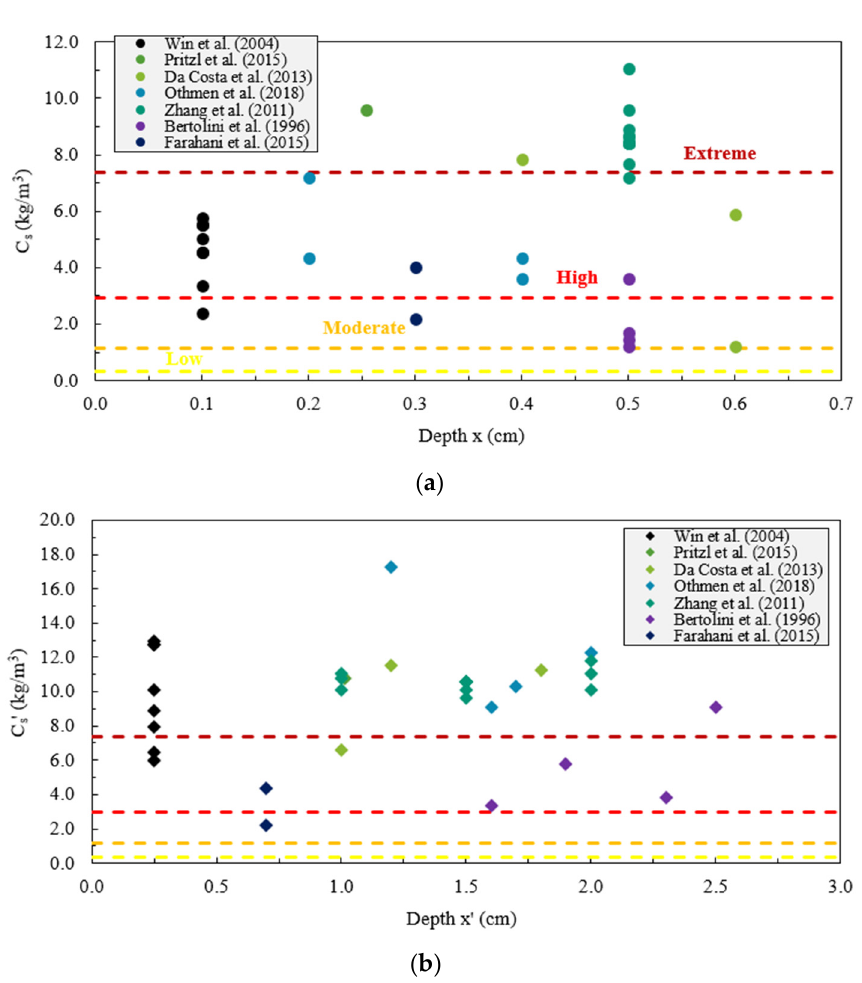
Figure 6. Collected data: ( a ) C s at depth x and ( b ) C s ’ at depth x’ retrieved from literature [13,25–30]. The horizontal lines indicate the four levels of aggressiveness (from low to extreme, Table 1).